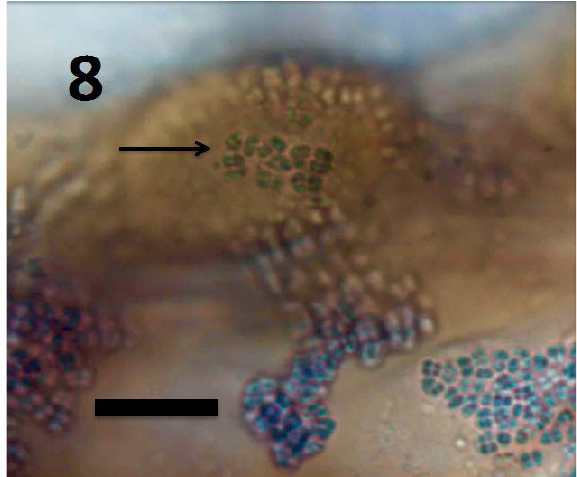
Figure 8. Root hair initial of Rumex crispus seedling showing M. luteus exiting root hair tip (arrow) and spilling off the sides of the root hair initial (bar = 10 µm; stained with 3,3-diaminobenzidine followed by aniline blue).